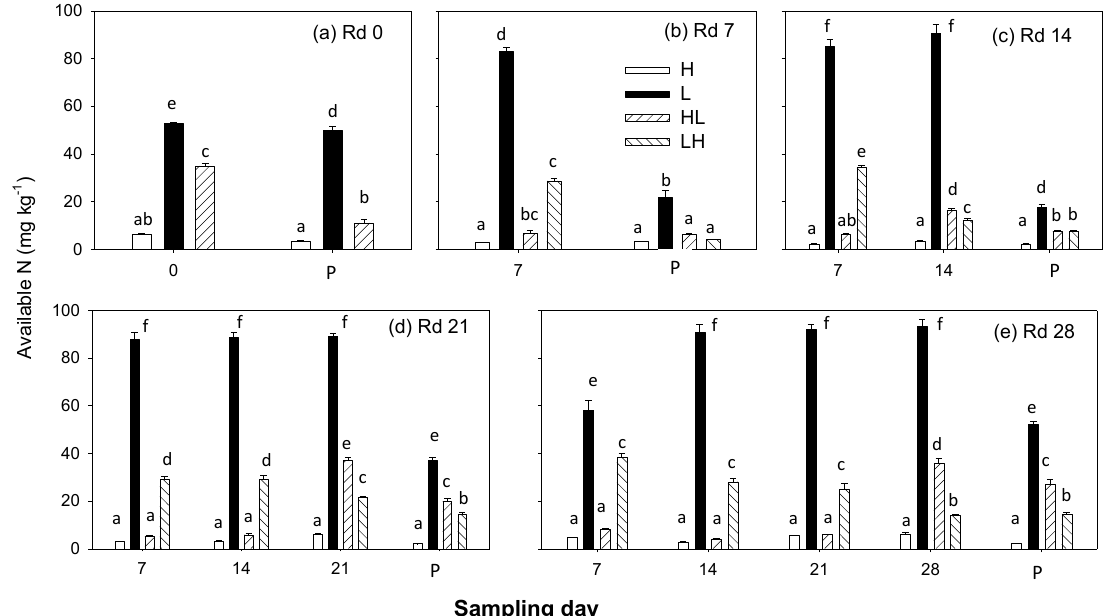
Fig. 1: Available N concentration on days 7, 14, 21, 28 and at plant harvest 28 days after planting (indicated by P) in treatments with only high C/N residue added (H), only low C/N residue added (L), high followed by low C/N (HL) or low followed by high (LH) where the second residue was added the same day as the first (a) or 7 (b), 14 (c), 21 (d) or 28 (e) days after the first (Rd0, Rd7, Rd14, Rd21, Rd28) 7 (a), 14 (b), 21 (c) or 28 (d) days after the first (Rd7, Rd14, Rd21, Rd28) (n=4 ± standard error). Columns within a treatment group with different letters are significantly different (P≤